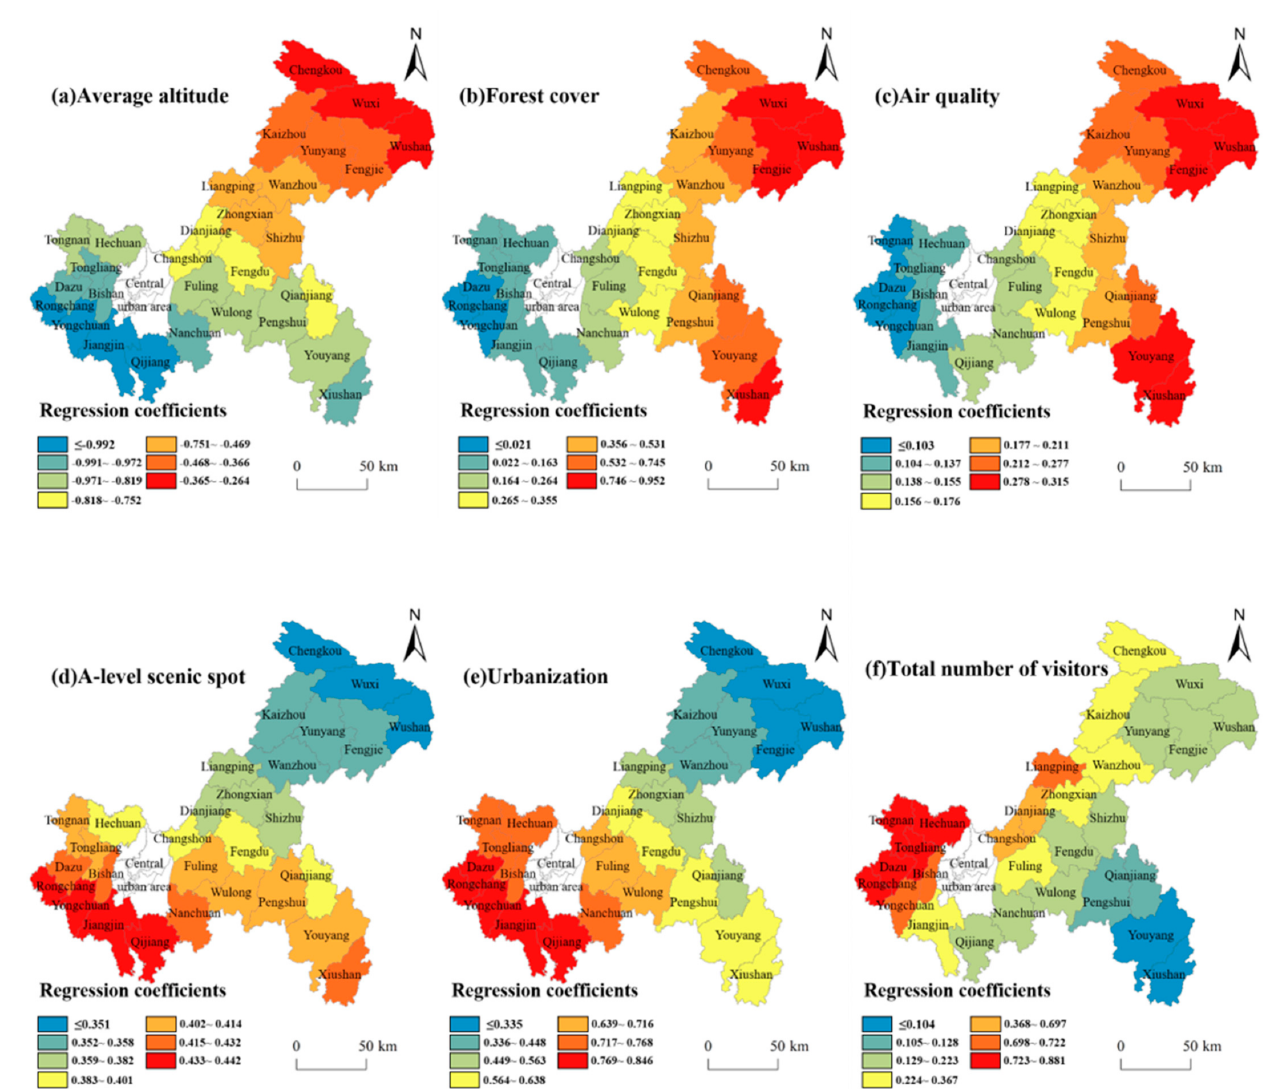
Figure 6. Spatial distribution of GWR model coefficients in non-central urban areas of Chongqing. Note: Based on the standard map (scale: 1:48 million) with the approval number of GS (2019) 1823 on the standard map service website, the base map was not